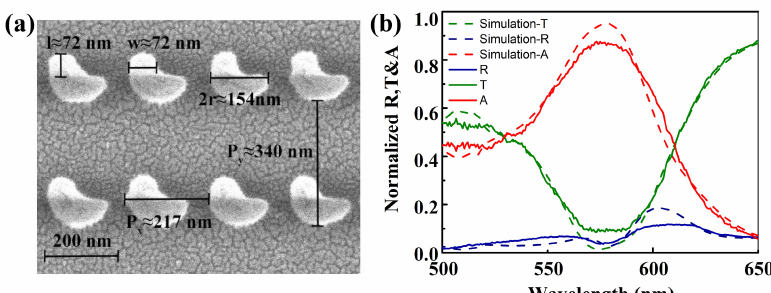
Figure 6. ( a ) The scanning electron microscopy (SEM) image of fabricated a-Si hook shaped nanostructure metasurface. ( b ) The measured reflection ( R , blu solid curve), transmission ( T , green solid curve) and absorption ( A , red solid curve) spectra of the fabricated metasurface. The simulated reflection, transmission and absorption of the metasurface are presented by the dashed